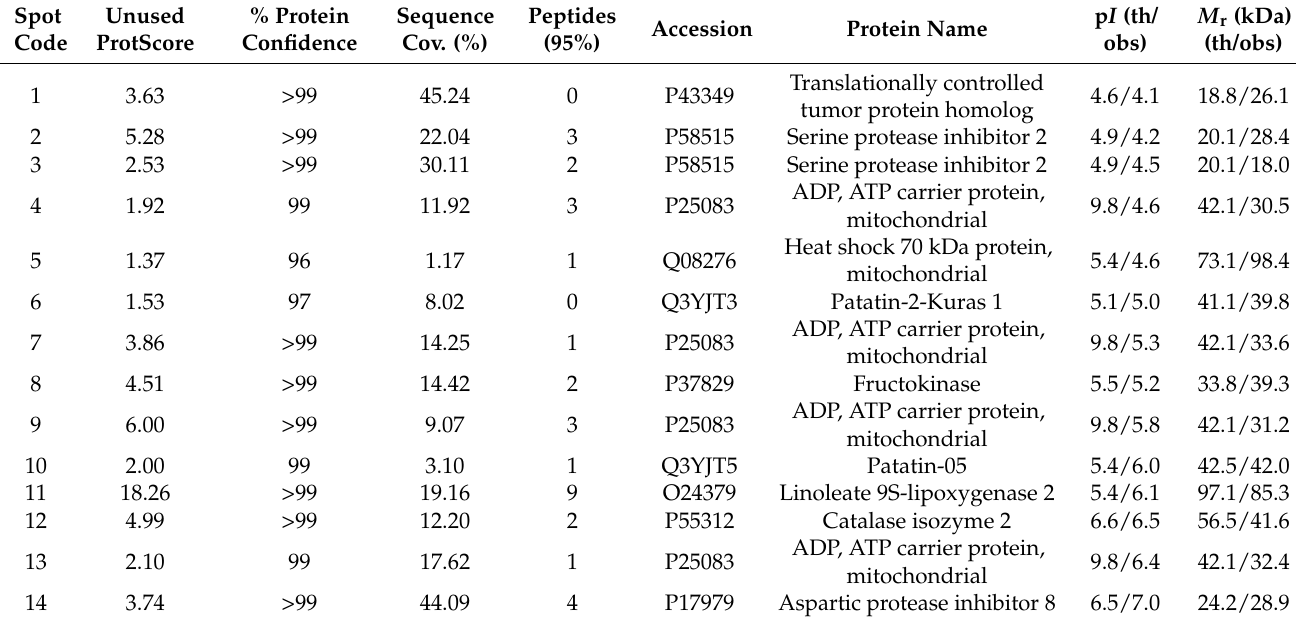
Table 2. List of spots hosting a single protein with statistically significant differential abundance ( p < 0.05) between pairs of potato cultivars that were identified by LC-TripleTOF